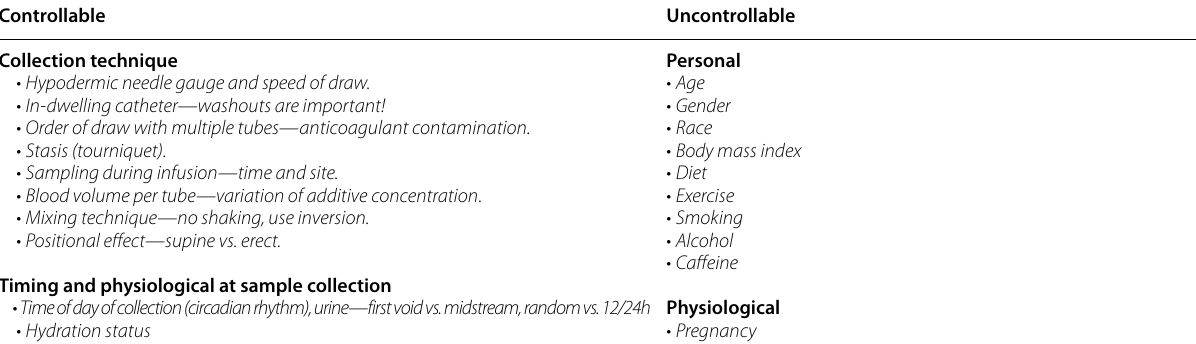
Table 2 Potential pre‑analytical variables* Potential pre-analytical variables in the measurement of biomarkers in biological fluids